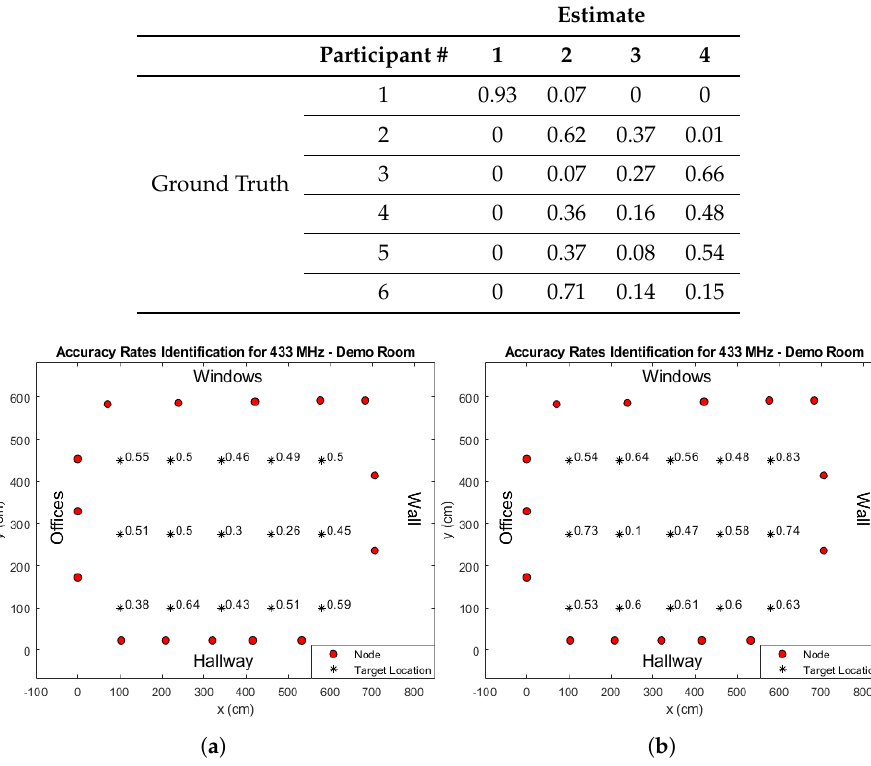
Figure 10. Identification accuracy rates for each location for both the ( a ) Euclidean distance minimization and ( b ) naive Bayesian classifier approach applied to 433 MHz RSS data. Table 12. Confusion matrix for identification based on an Euclidean distance minimization approach applied to RSS data from the 868 MHz